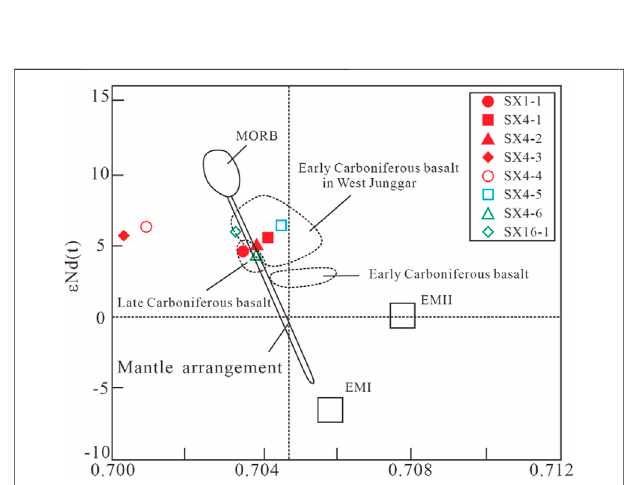
FIGURE 10 | Sr-Nd isotopic characteristics of Carboniferous volcanic rocks in the Shixi area.